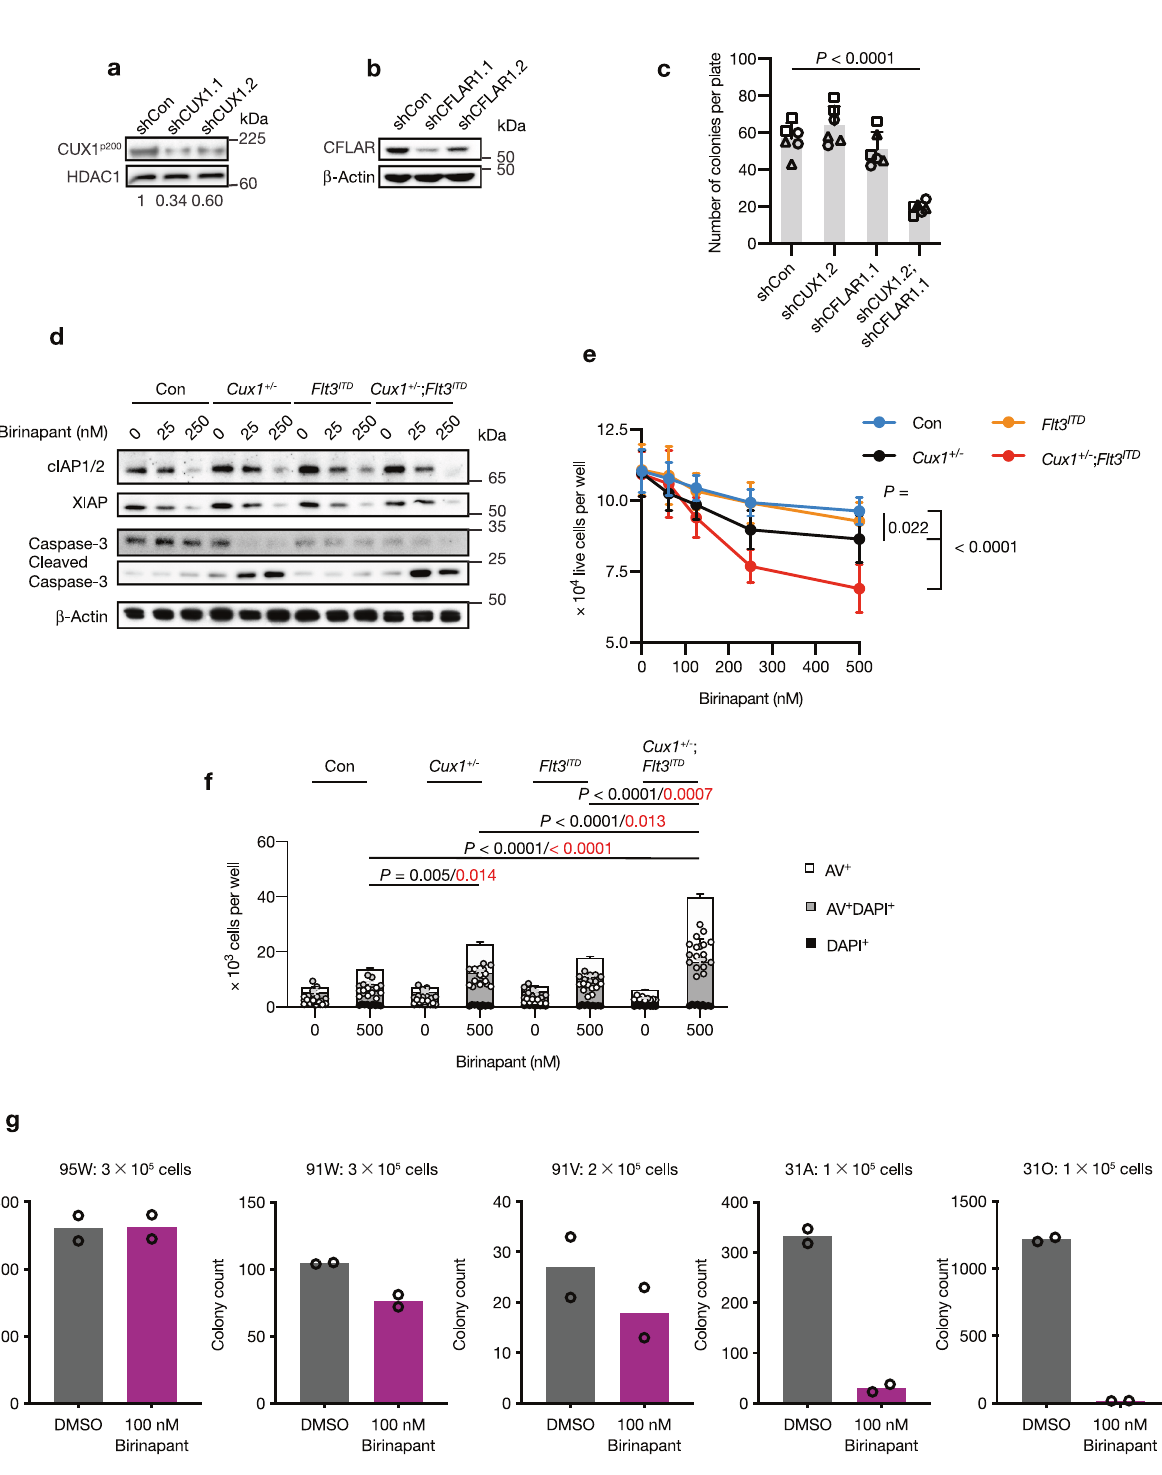
six-well plates. Cells were incubated at 37 °C in 5% CO 2 for a further 48 h before use in downstream experiments. Puromycin was added to 1 µg/ml to select for transduced cells where required. Doxycycline (Sigma) was added to 1 µg/ml to induce shRNA expression in methylcellulose assays. Human CD34 + bone marrow cells from healthy donors were incubated for two days in StemPro-34 (Gibco) supplemented with StemPro Nutrient Supplement, glutamine, penicillin/streptomycin, human SCF (50ng/µl), human thrombopoietin (150ng/µl), human Flt3L (50ng/µl) and human IL-6 (50ng/µl) before virus transduction by spinoculation as above. Transduced cells were isolated by sorting for GFP and mCherry expression 48h later prior to plating into methylcellulose